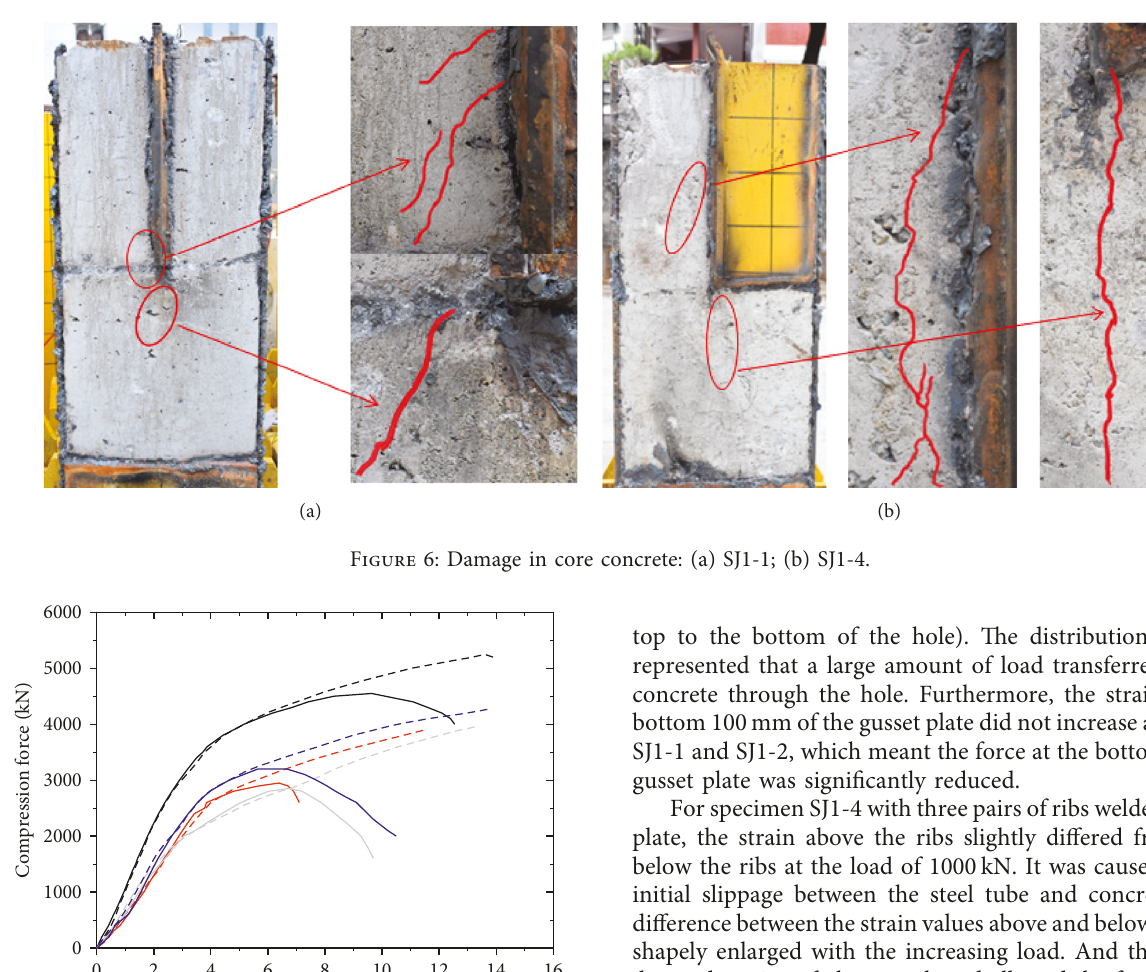
Figure 5: Failure patterns: (a) slippage; (b) buckling in the gusset plate; (c) expansion deformation in the tube.